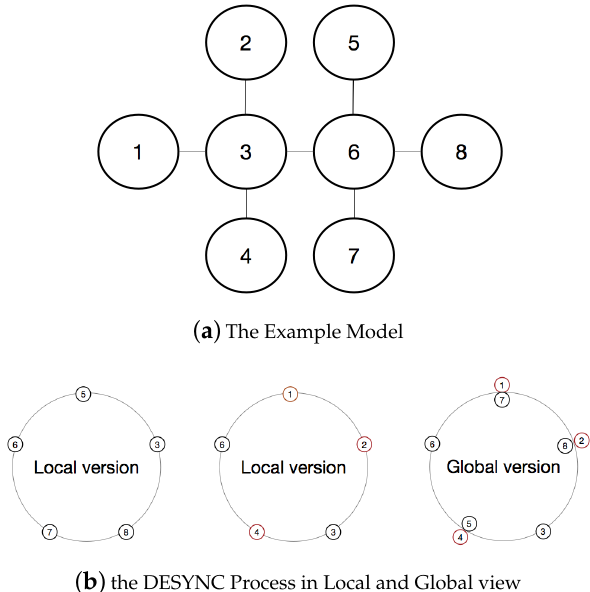
Figure 8. The model of example